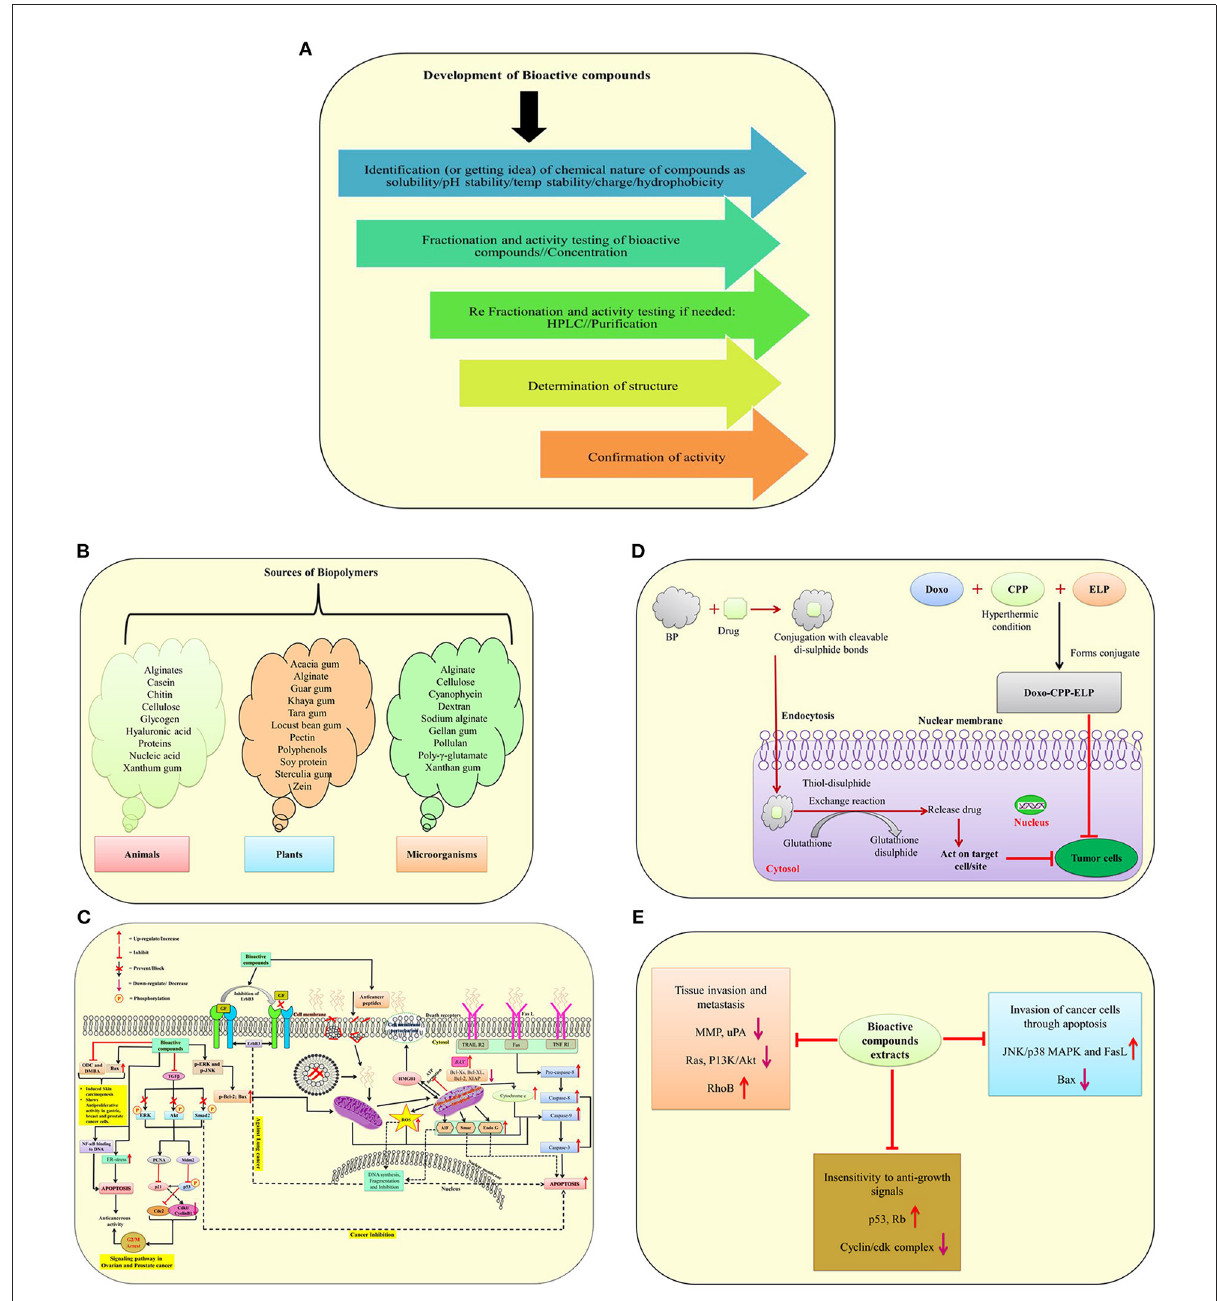
FIGURE2 A schematic illustration of bioactive molecule sources and development, as well as their involvement in drug delivery systems and molecular mechanisms against different cancer cells. (A) Development of bioactive compounds; (B) Sources of biopolymers from plants, animals and microorganisms; (C) Mode of action of anticancerous molecules via TGF– β signaling pathway, death receptor, mitochondrial receptor–induced pathways against cancer cells; (D) A mechanism of suppressing tumor cells using biopolymers in conjunction with drugs; (E) The effect of bioactive molecules from plant extracts on the underlying mechanisms of cancer development [modified and adapted from Lin et al. (76)]. ODC, Ornithine decarboxylase; DMBA, 7,12-Dimethylbenz( α )anthracene; Bcl-2, B-cell lymphoma 2; Bax, Bcl-2-associated X protein; NF-Kb, Transcription factor; p-ERK, Protein kinase RNA-like ER kinase; ROS, Reactive oxygen species; ENK, c-Jun-N terminal kinase; AIF, Apoptosis-inducing factor; FasL, Fas Ligand; ErbB3, Receptor tyrosine kinase; TGF- β , Transforming growth factor beta; ERK, Extracellular-signal-regulated kinase; AKT1, Serine/threonine-protein kinase; SMAD2, SMAD family member 2; Mdm2, Mouse double minute 2 homolog; PCNA, Proliferating cell nuclear antigen; p53 and p21, Tumor protein; WAF1/CIP1, Wildtype activating factor-1/cyclin-dependent kinase inhibitory protein-1; cdc2, Cell division cycle 2; HMGB1, High mobility group box 1; Smac, Second mitochondria-derived activator of caspase; EndoG, Endonuclease G; ER, Endoplasmic reticulum; TRAIL, Tumor necrosis factor (TNF)-related apoptosis-inducing ligand; TNF RI, Tumor necrosis factor receptor 1; Rb, Retinoblastoma protein; PI3K, Phosphatidylinositol-3-kinase; uPA, Urokinase plasminogen activator; BP,